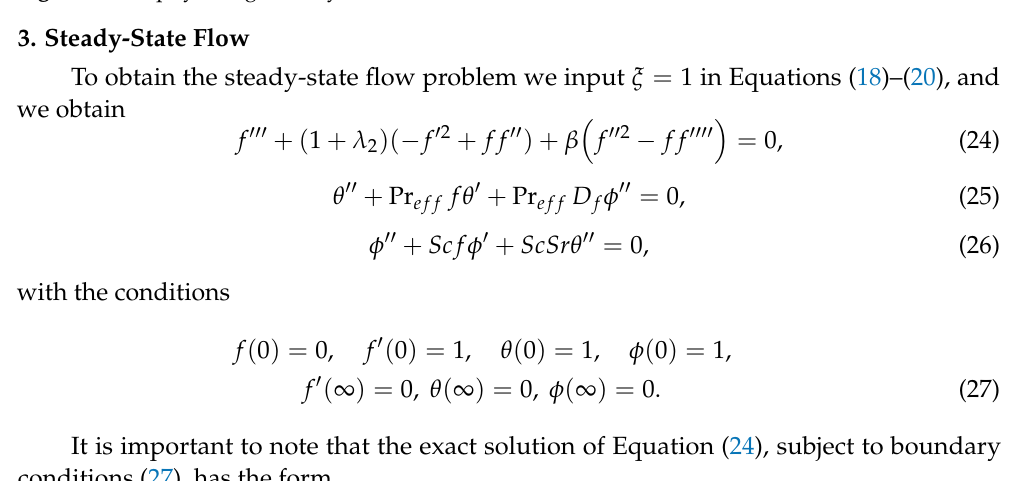
Figure 1. The physical geometry of the fluid